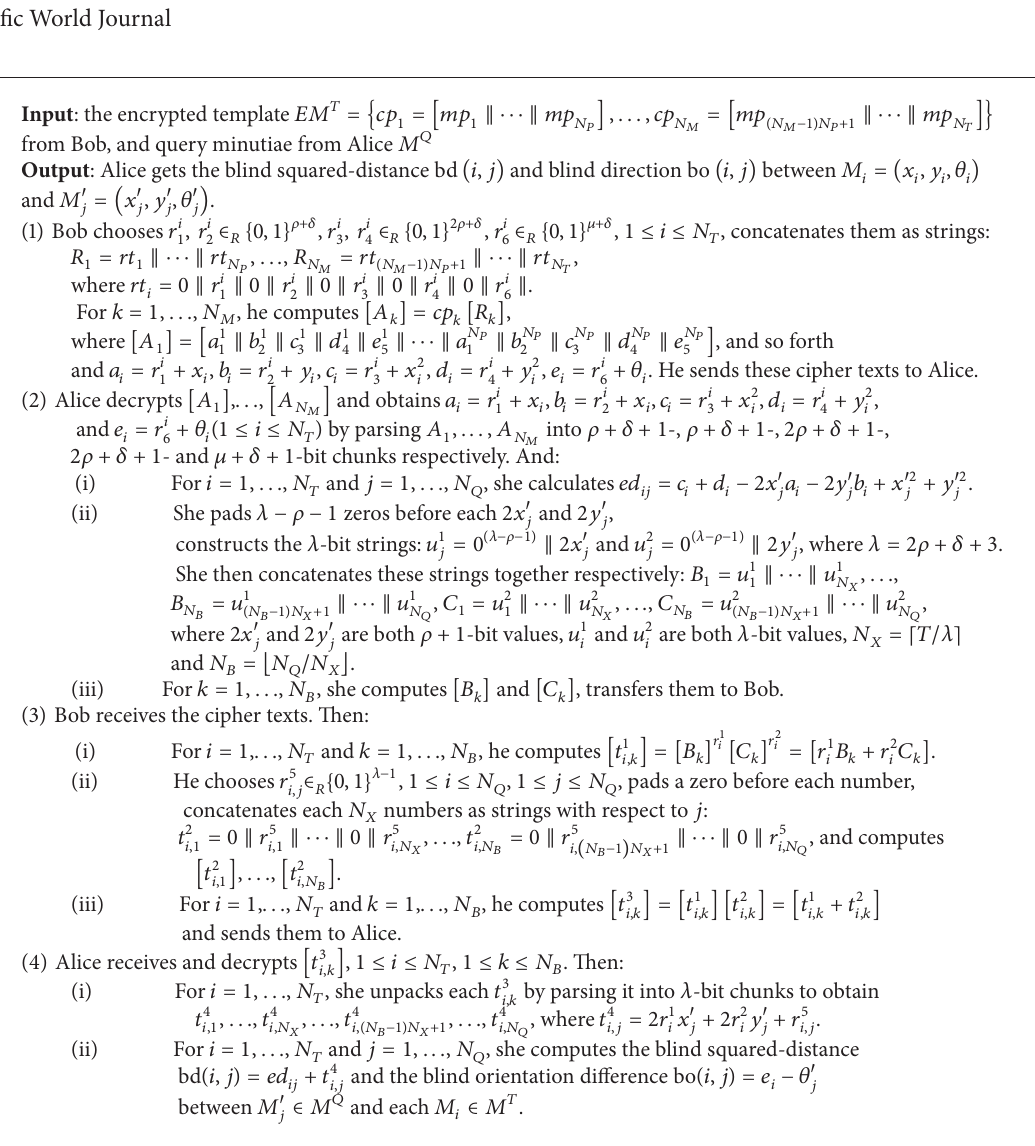
Algorithm 1: Euclidean-distance ( 𝐸𝑀 𝑇 , 𝑀 𝑄